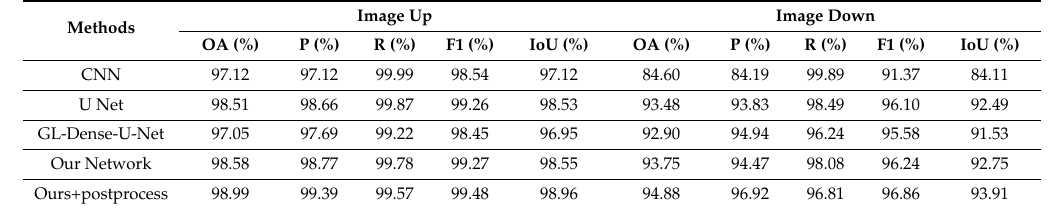
Table 7. The statistics of the accuracy of the extracted results in Figure 10 with different methods.